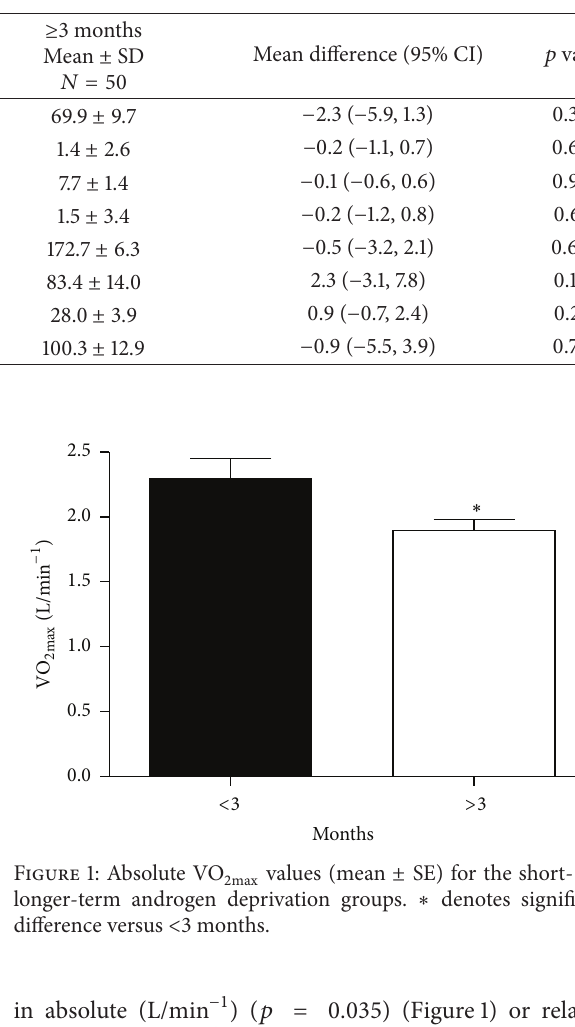
Table 1: Subject characteristics for the short- and longer-term androgen deprivation groups.